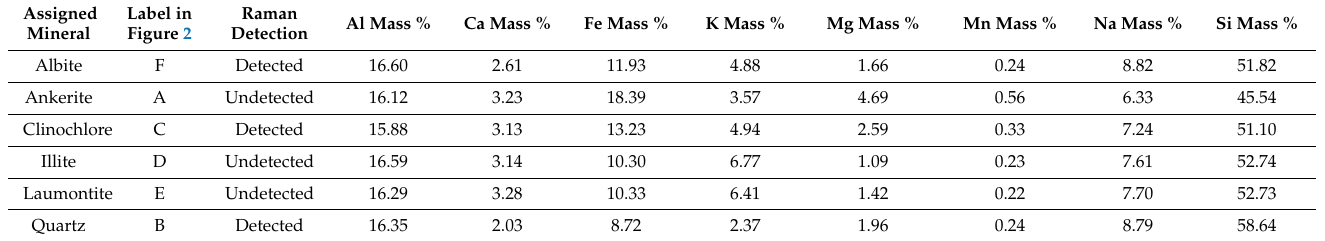
Table 3. Point analysis results from XRF and Raman: mass percent from the XRF and detection from Raman of the selected 20 µ m spots in Figure 2. Note that for the XRF mass percentages, other trace elements detected were ignored, as they were not in the minerals detected by XRD. Additionally, it should be noted the mass percentages across the various minerals showed elements not found in their respective minerals, as the X-ray spot size also exposed the matrix minerals of albite and